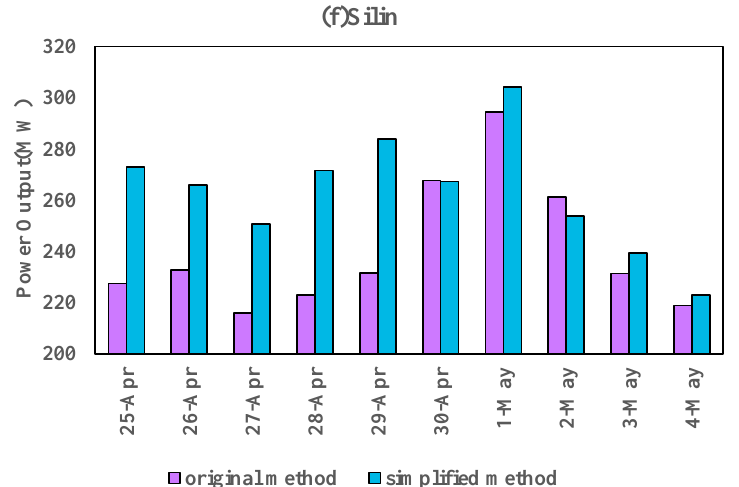
Figure 6. The Power Output Process of Each Reservoir in Wujiang River Obtained by the Simplified Solution Method and the Original Solution Method.